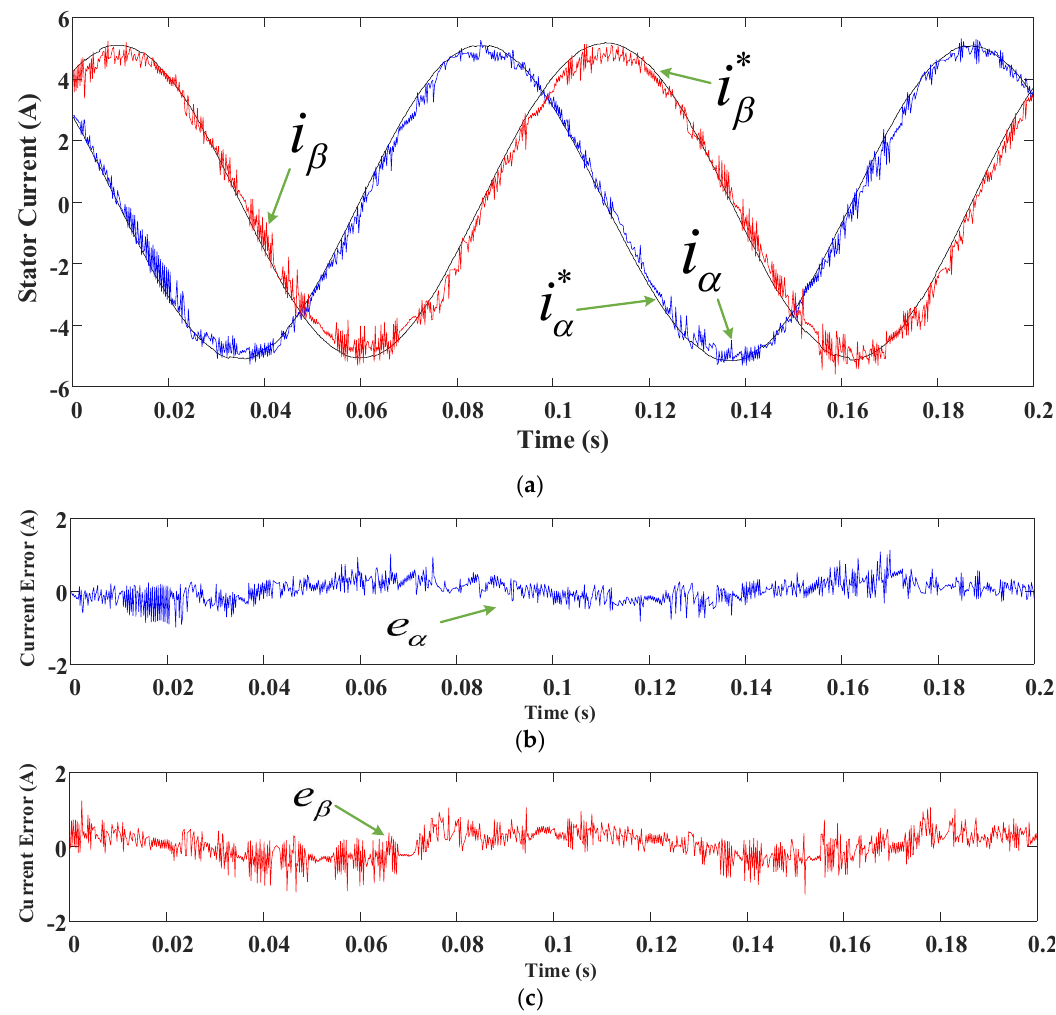
Figure 10. Experimental results of SVV-MFPCC under speed 300 rpm and load 2 Nm (case 1): ( a ) current responses; ( b ) α -axis current error; ( c ) β -axis current error.